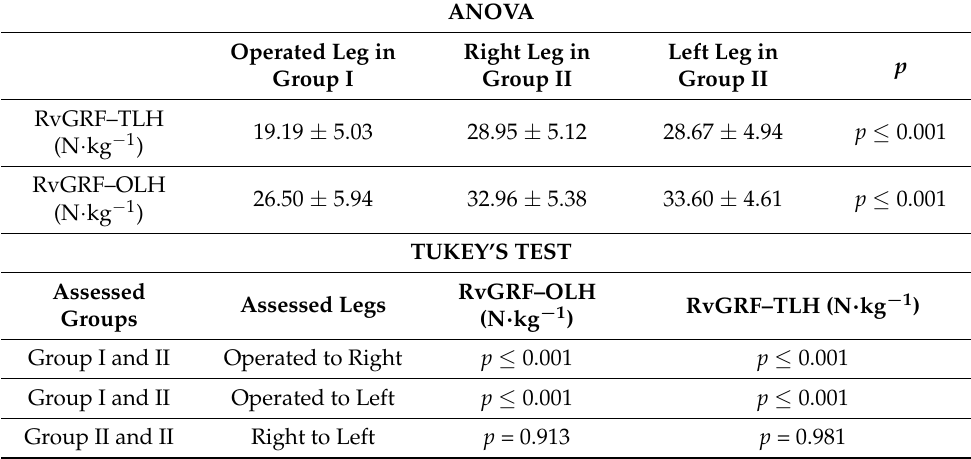
Table 3. The between-group comparative analysis using ANOVA and Tukey’s test to determine significant differences in the vertical ground reaction force component during two- and one-legged vertical hops for Group I and in the right and left legs for Group II.